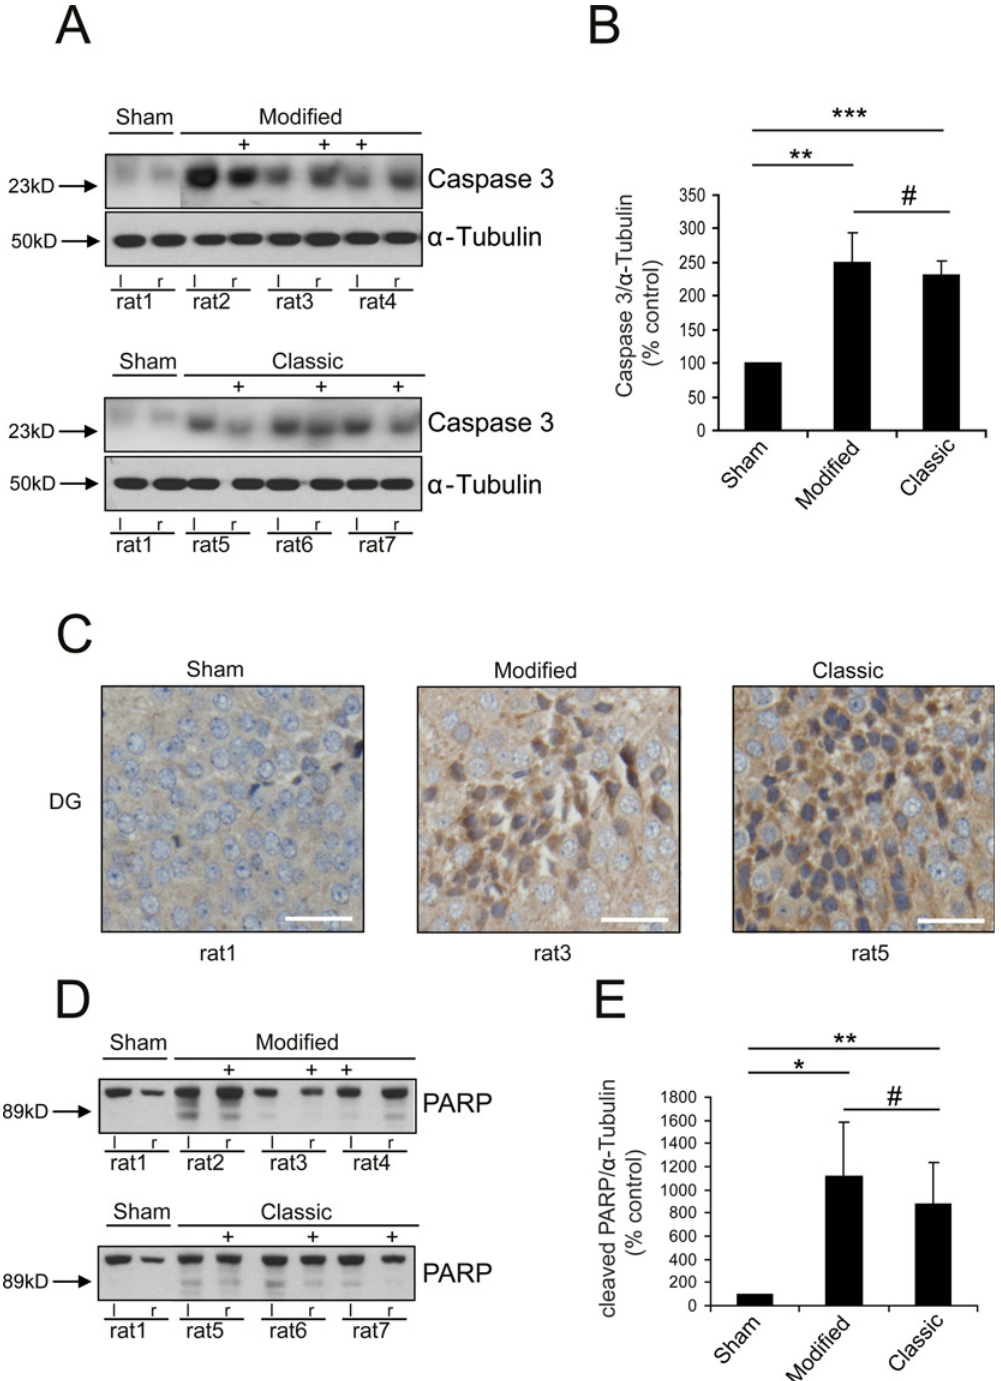
Fig 6. Induction of apoptotic signaling. Western Blots show an increase of caspase 3 expression (A) and PARP cleavage (D) in SAH animals (Location of ICP-probe is hallmarked (+)). Immunohistochemical staining for caspase 3 (C) confirms these results (right lower corner: bar indicates 20 μ m). Semiquantitative analysis of protein expression demonstrates significant increase of caspase 3 (B) and PARP cleavage (E) in SAH animals (independent from technique). ( *** p < 0.001; ** p < 0.01; * p < 0.05; # p > 0.05)